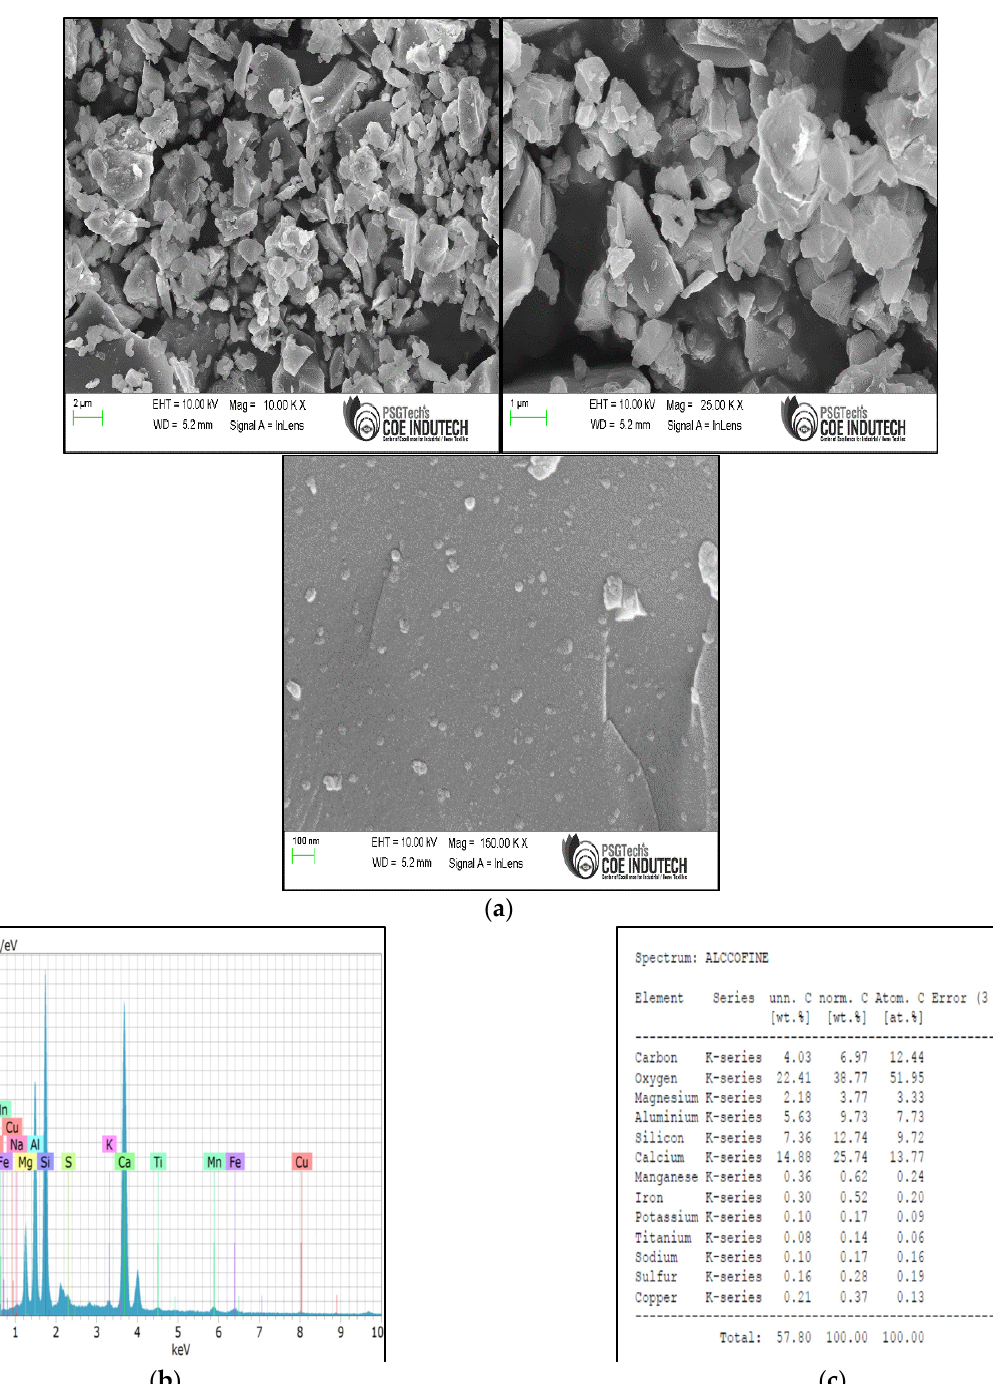
Figure 5. ( a ) Field emission scanning electron microscope images of alccofine. ( b , c ) Energy dispersive X-ray analysis of alccofine.